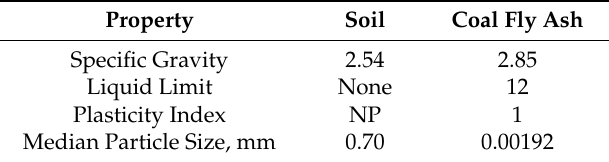
Table 1. Physical properties of raw materials.